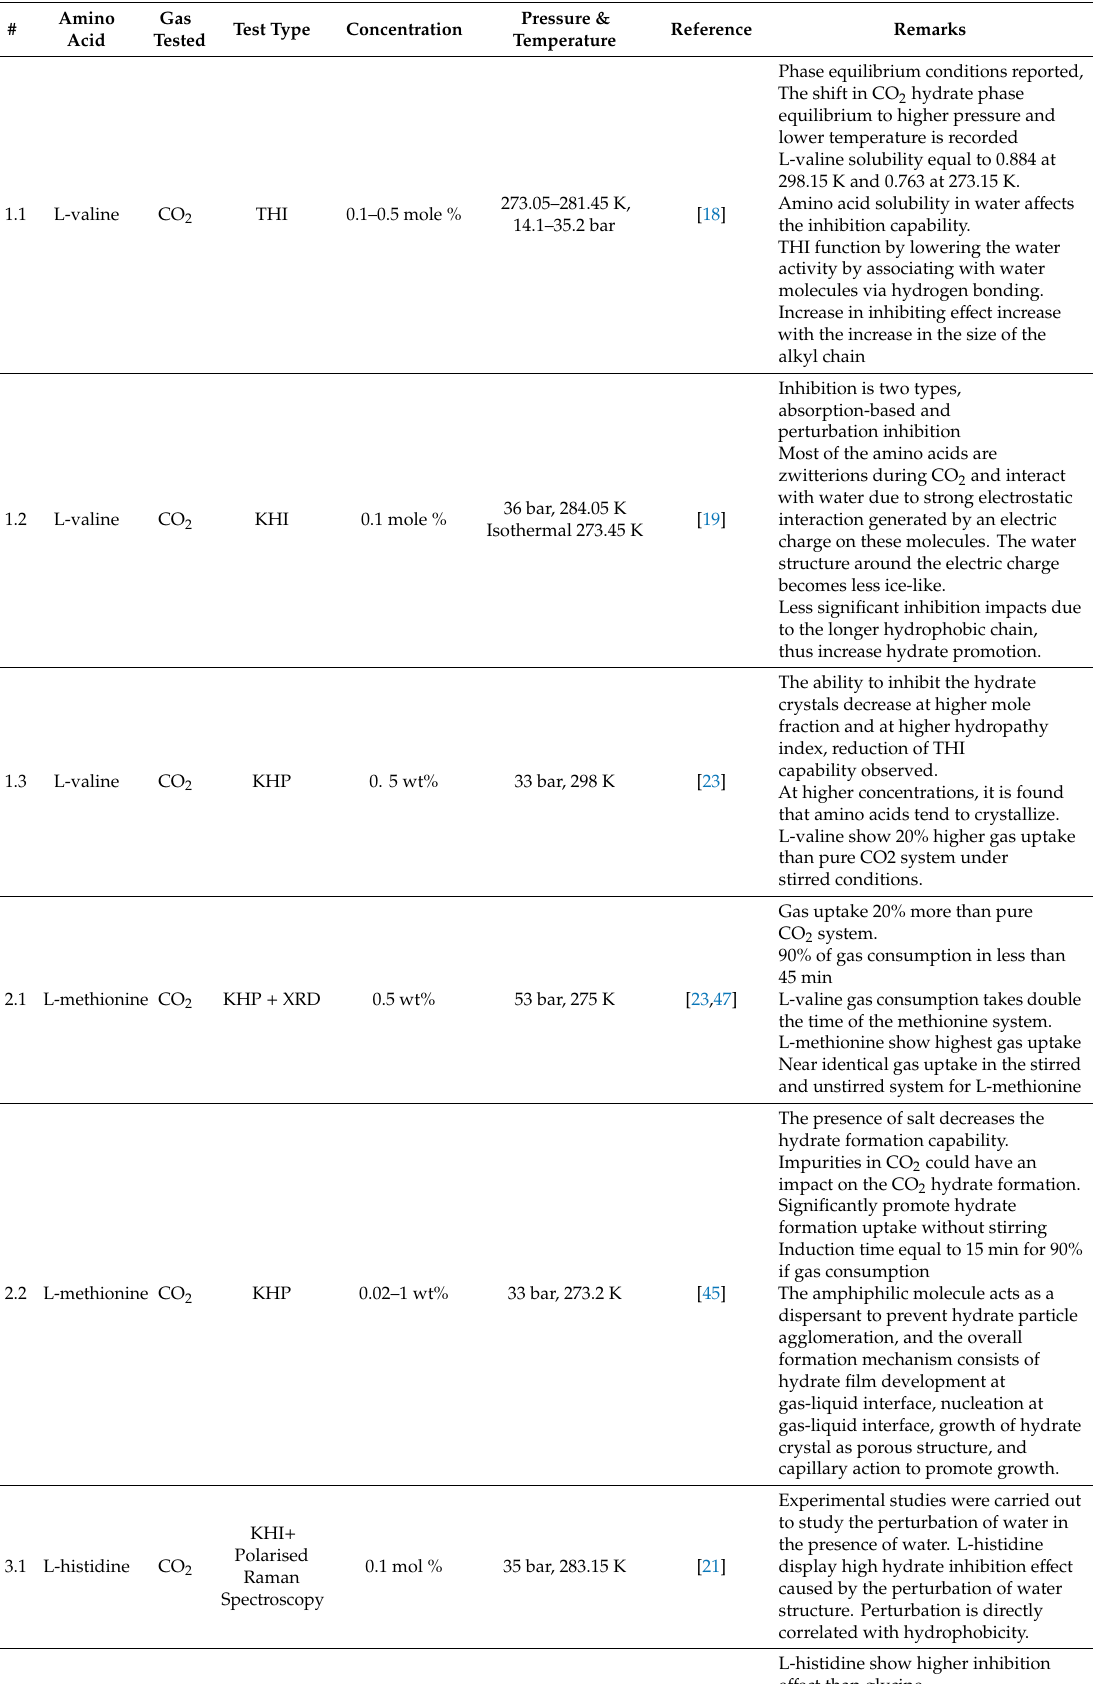
Table 10. Literature review of selected amino acids for CO 2 hydrate